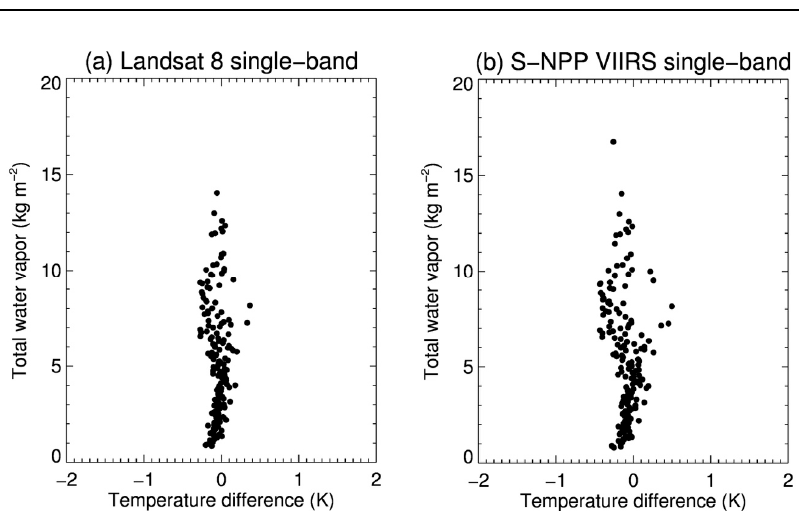
( b ) Landsat 8 single-band using Equation (2), and ( c ) S-NPP VIIRS single-band for I5 band using Equation (2).